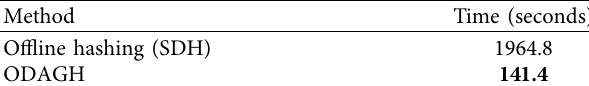
Figure 2: PR curves of all compared methods on Market-1501 dataset. Table 3: Comparison of total training time.